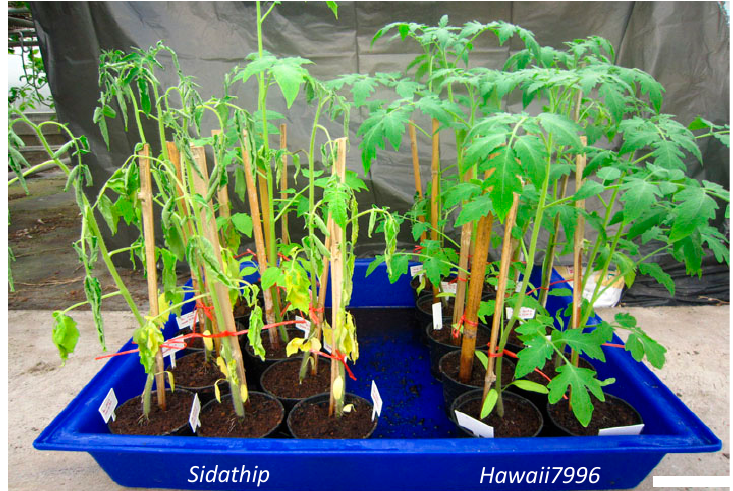
Figure 1. Susceptible tomatoes cv. Sidathip and resistant tomatoes cv. Hawaii7996 inoculated with R. solanacearum and symptoms development. Susceptible plants showed wilt symptoms after 7 dpi whereas the resistant Hawaii7996 showed no symptoms. Bar = 10